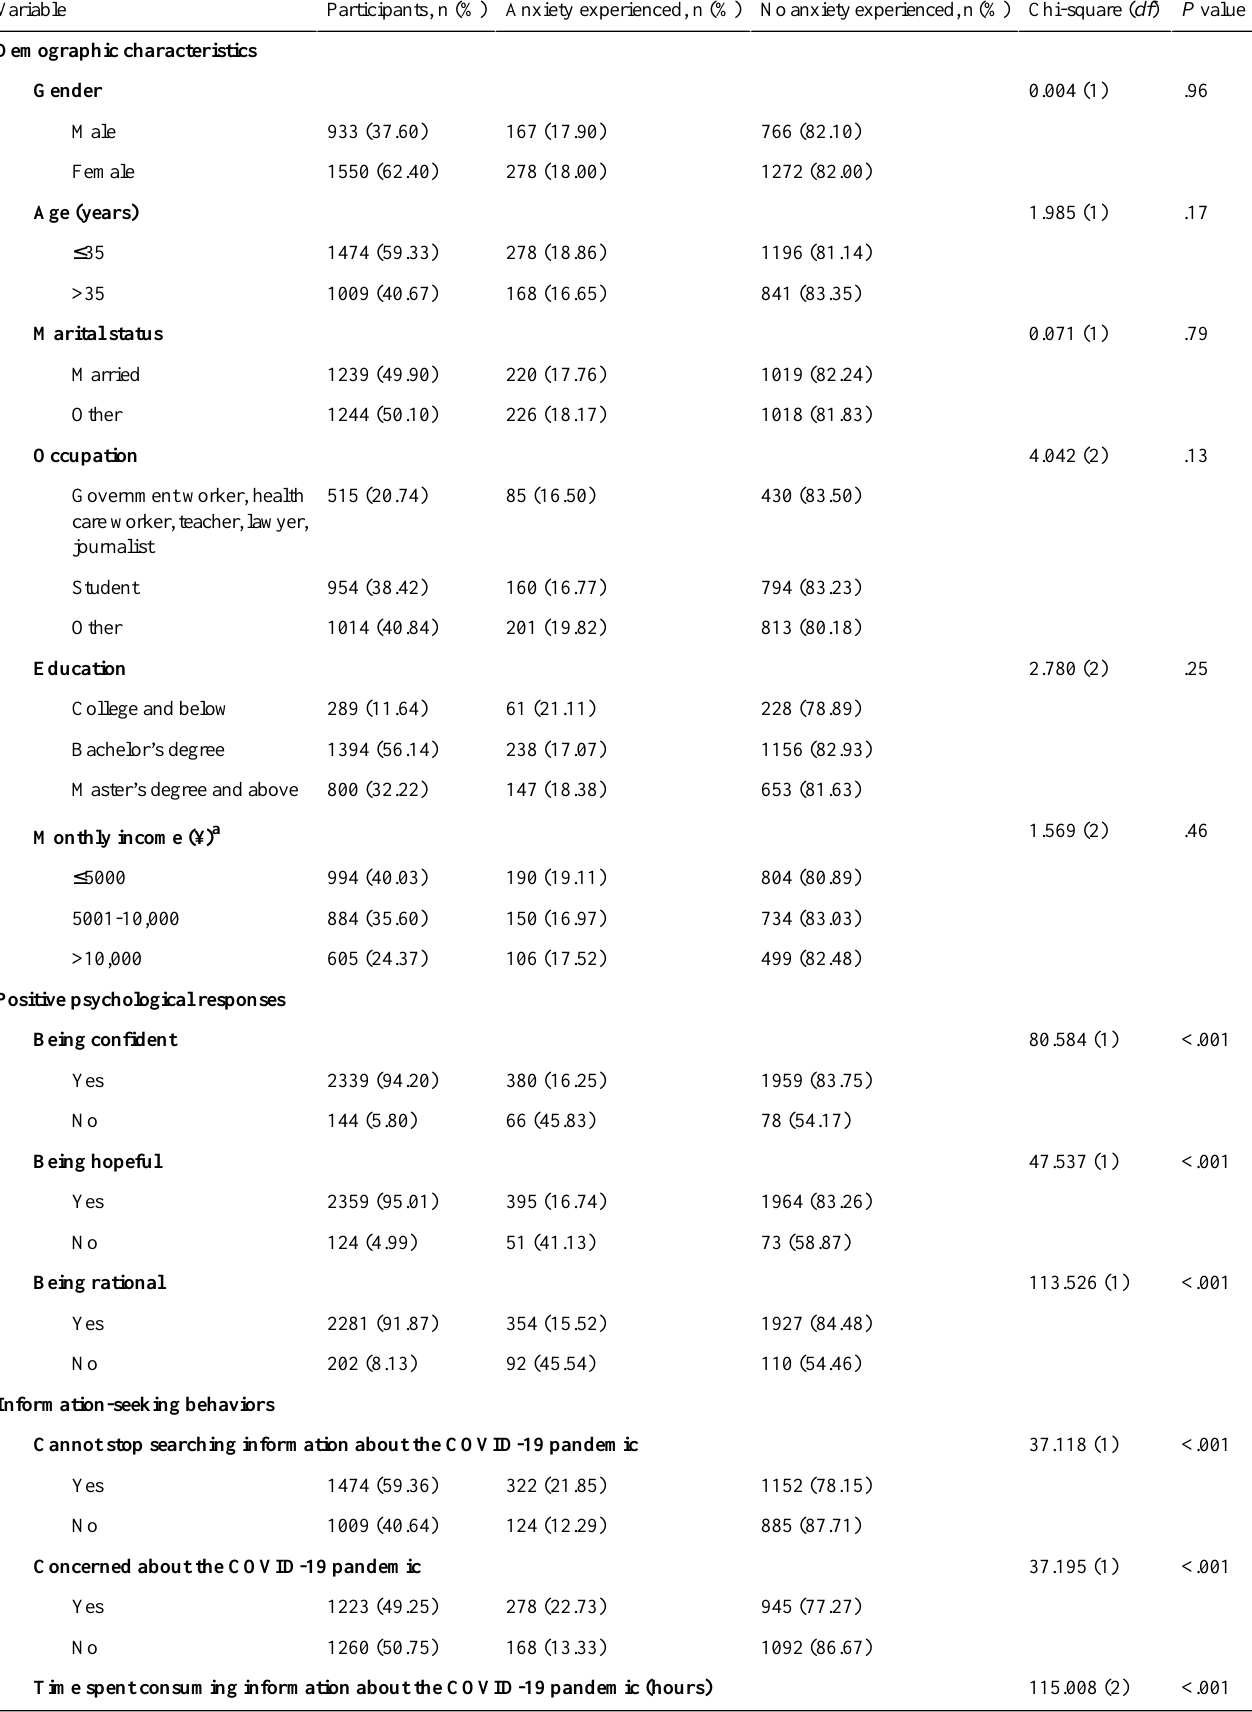
Table 1. Prevalence of anxiety and associated factors among study participants